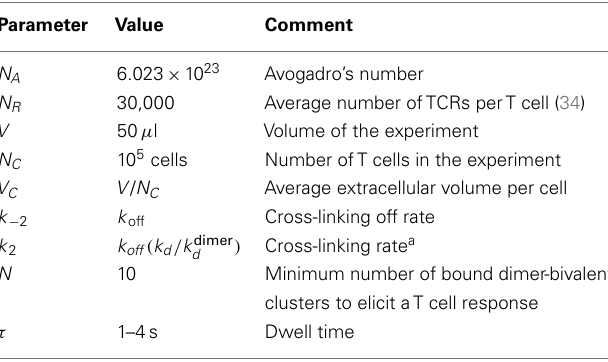
Table 1 | Summary of the parameters used in the stochastic